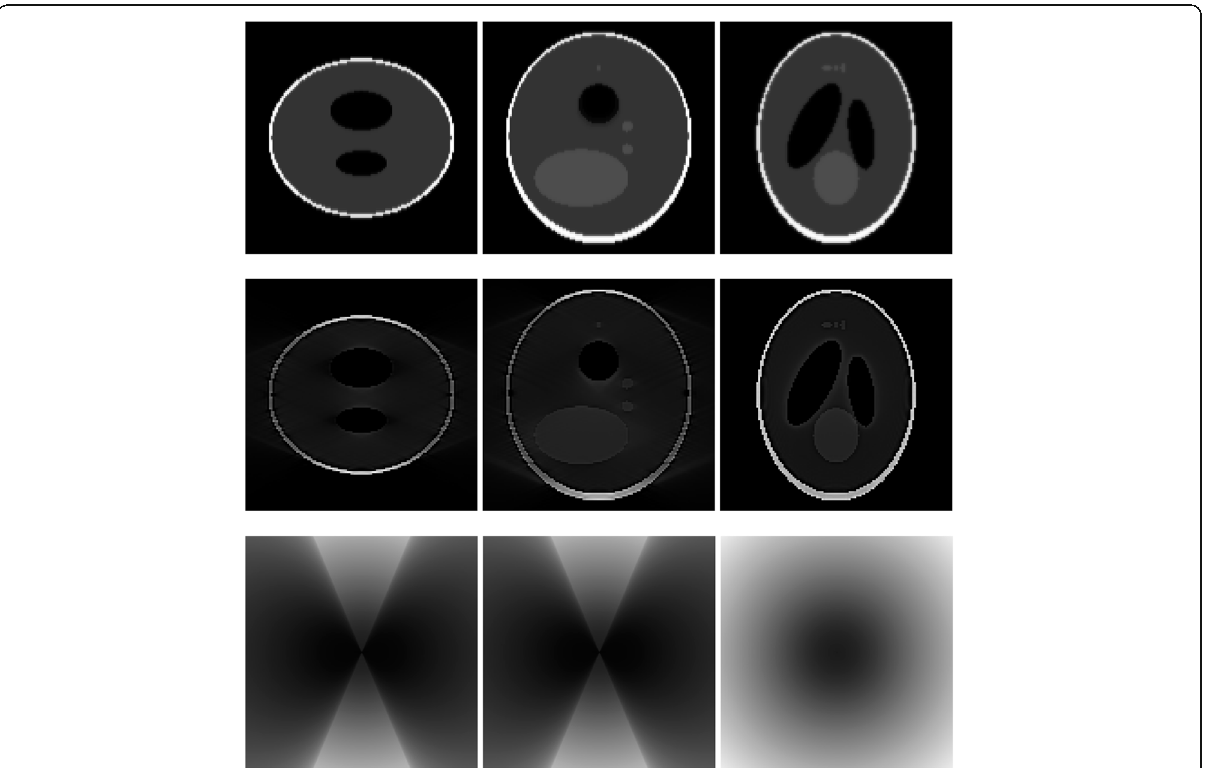
Fig. 3 Image reconstruction using proposed algorithm for the case of ψ = π /8 and σ = 1. Row 1 : TOF backprojection. Row 2 : Final reconstruction. Row 3 : Tomographic filter H . Three central orthogonal cuts are shown for each